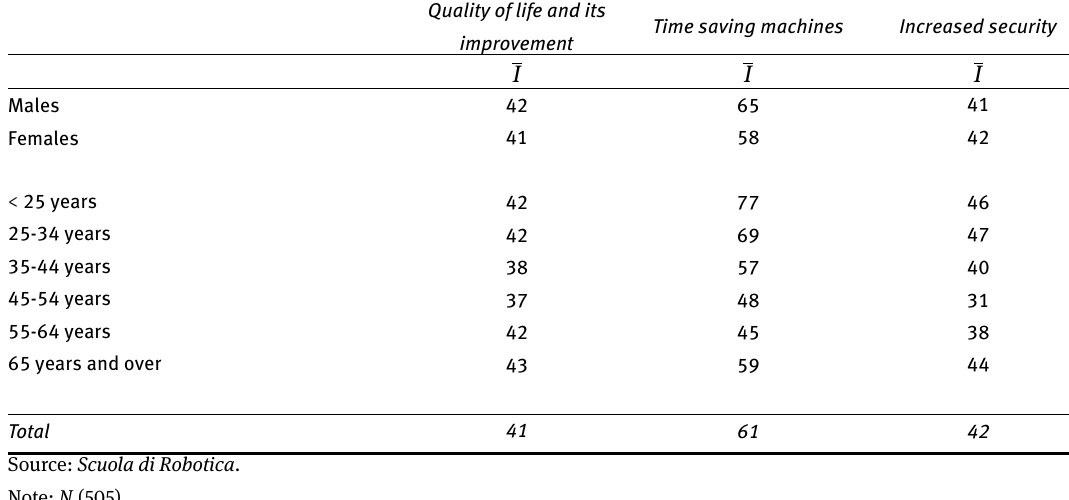
Table 8: The spread of robots in society and problems of safety, loss of jobs, restriction of freedom. Trust indexes. Quality of life and its